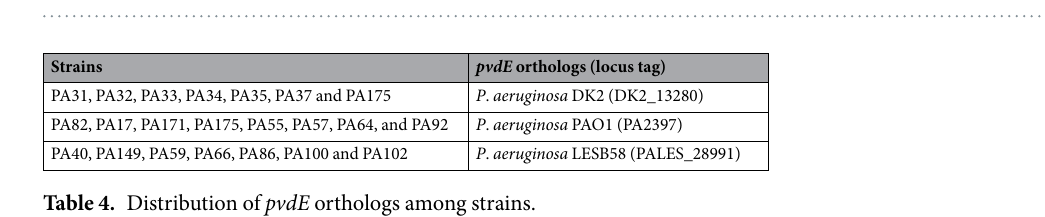
Table 4. Distribution of pvdE orthologs among